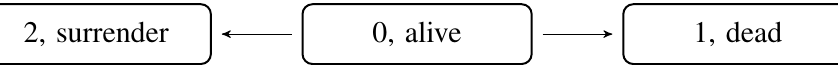
Figure 2. Survival Markov model with